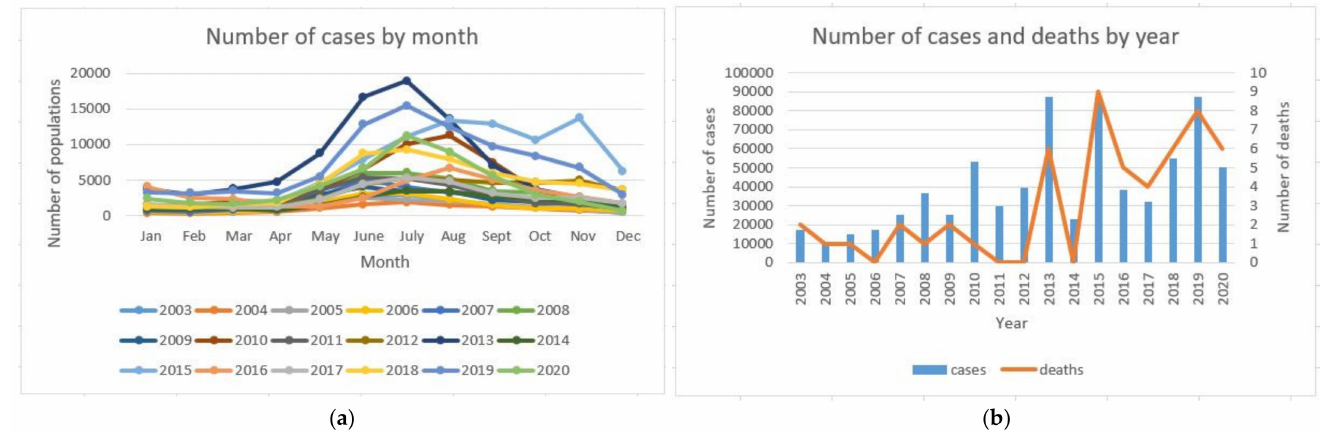
Figure 1. The number of cases by month and the number of cases and deaths each year from 2003–2020 [29]: ( a ) the number of cases by month; ( b ) the number of cases and deaths by